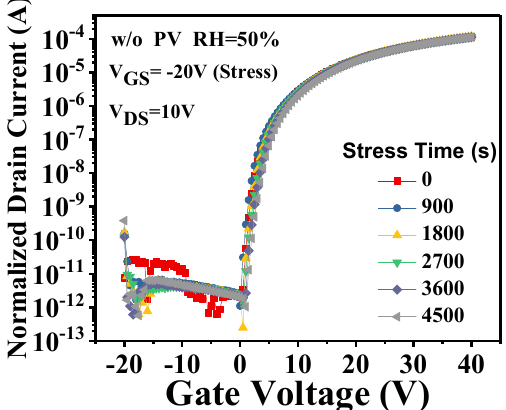
Figure 3. Transfer characteristics of the unpassivated a-IGZO TFTs as a function of the negative gate bias-stress (NGBS) time under RH = 50%.